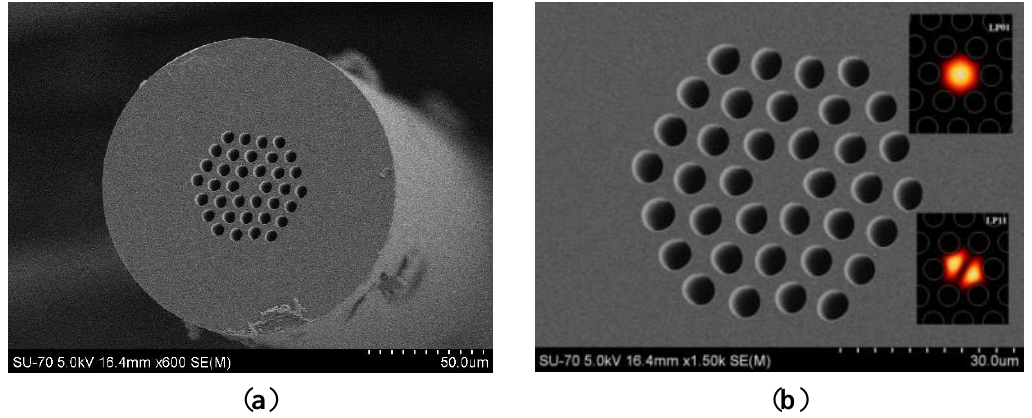
Figure 1. The structure of PCF. ( a ) the whole cross section, ( b ) the enlarged microstructured region. The insets in ( b ) were calculated mode distribution of fundamental mode and 2nd